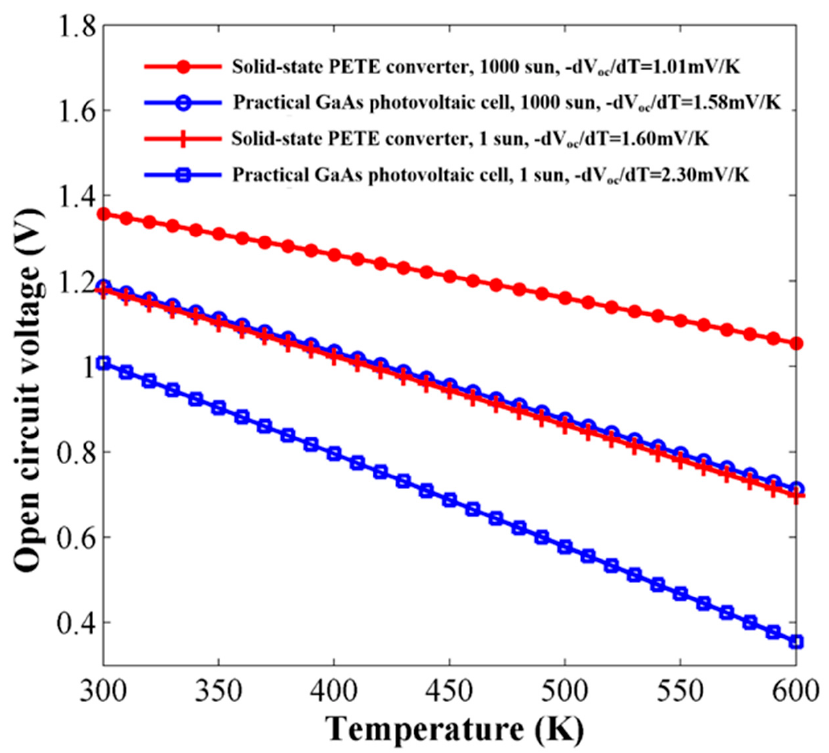
Figure 3. Variations in V oc with temperature for the solid-state PETE converter with GaAs absorption layer and practical GaAs photovoltaic cell under di ff erent flux concentration levels. 28 Increasing the irradiance concentration increased (cid:1848)